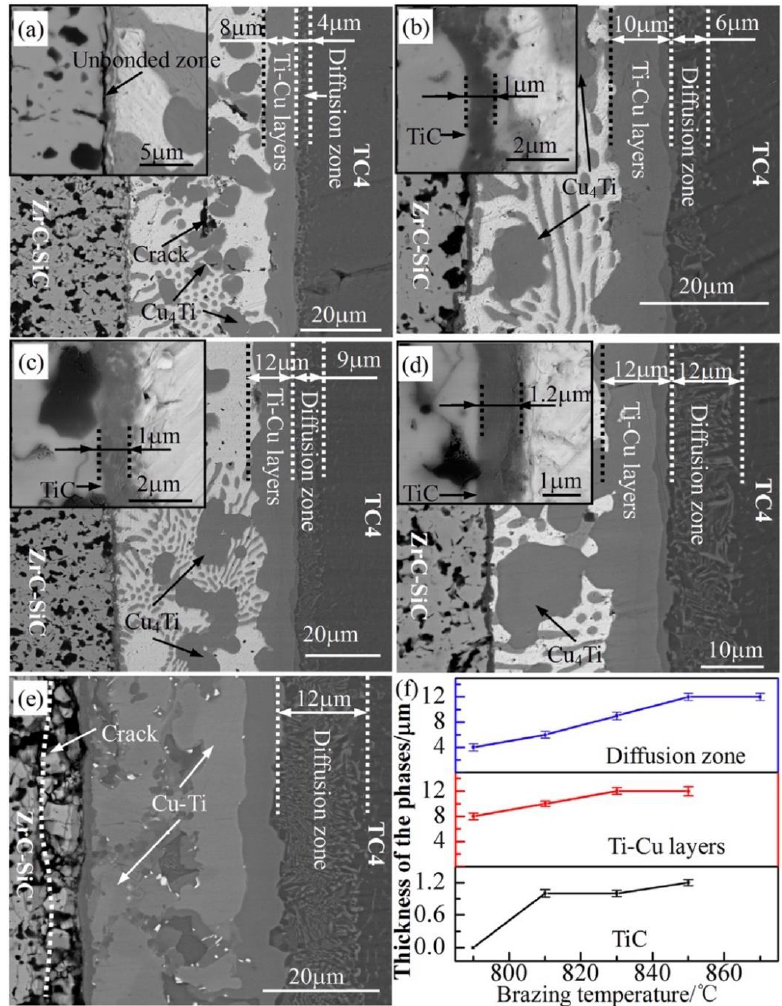
Figure 15. Effect of brazing temperature on the microstructures of joints brazed at: ( a ) 790 °C, ( b ) 810 °C, ( c ) 830 °C, ( d ) 850 °C, ( e ) 870 °C and ( f ) the evolution of the thickness of the phases with the brazing ( c ) 830 ◦ C, ( d ) 850 ◦ C, ( e ) 870 ◦ C and ( f ) the evolution of the thickness of the phases with the brazing temperature, reproduced from Reference [40] with permission of Elsevier, 2017. temperature, reproduced from Reference [40] with permission of Elsevier,